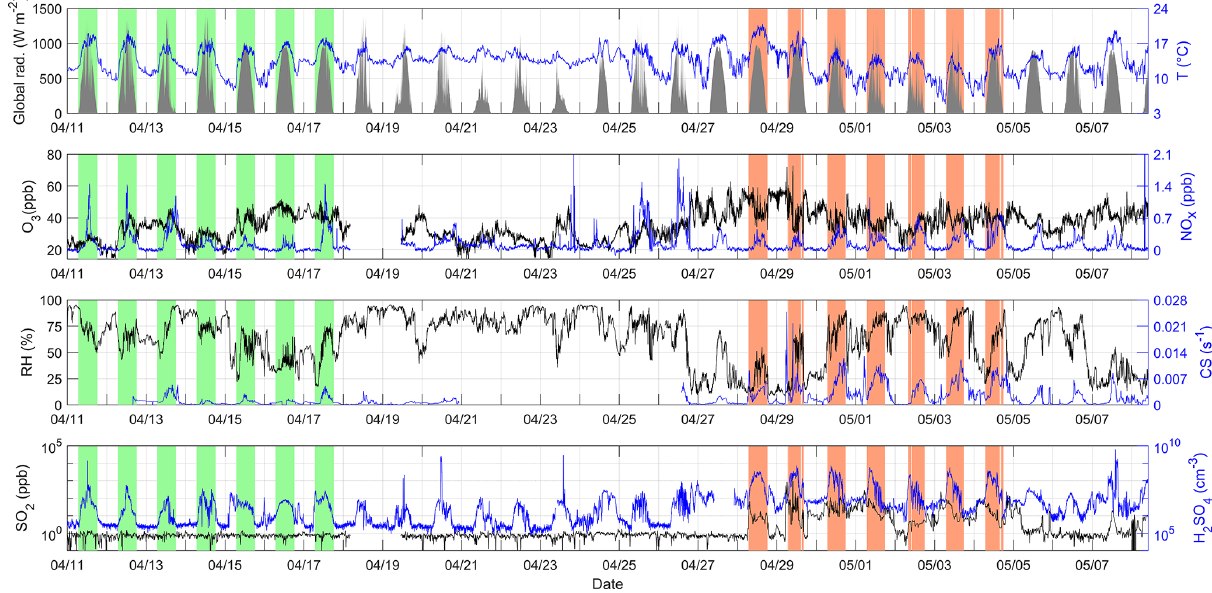
Figure 1. Overview of the conditions during the OCTAVE campaign conducted in 2018. All time series are shown in local time (UTC + 4) for easier interpretation of the diurnal cycles. Measurements performed under daytime regular conditions and used to derive the correspond- ing statistics reported in Table 1 are highlighted by the green shaded areas; similarly, data collected under daytime plume conditions are highlighted by the red shaded areas. Note that with the exception of radiation, which is represented by the grey area in the top panel, the black line represents the variable on the left y axis, and the blue line represents the variable on the right y axis in all other panels. This information on line colour is not directly provided in the plot to preserve the readability of the